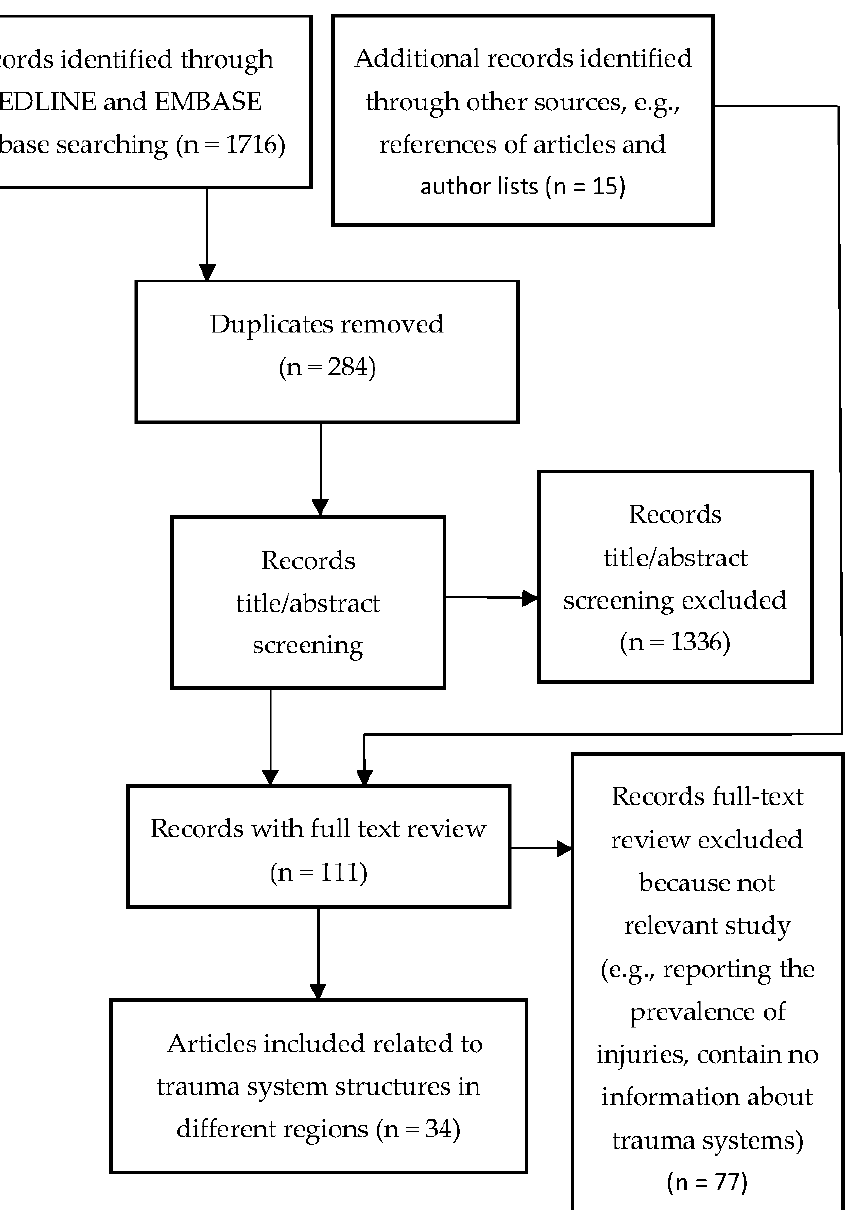
Figure 2. PRISMA flow diagram showing the searching and screening processes.